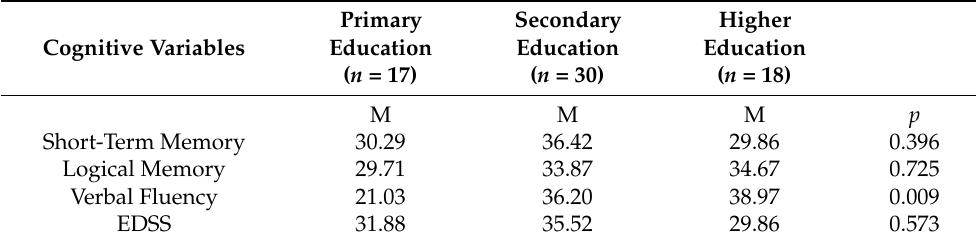
Table 6. Relationships between cognitive variables and educational level.